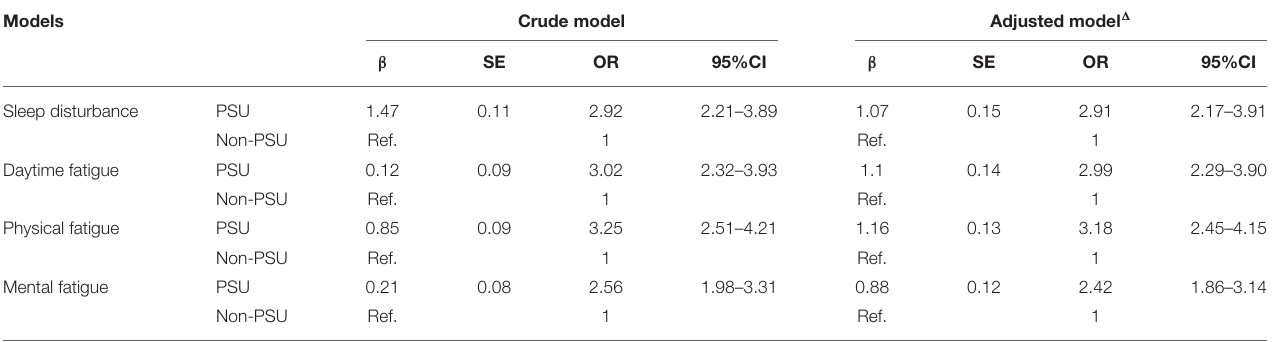
TABLE 3 | Logistic regression analyses of PSU on sleep disturbance and fatigue.